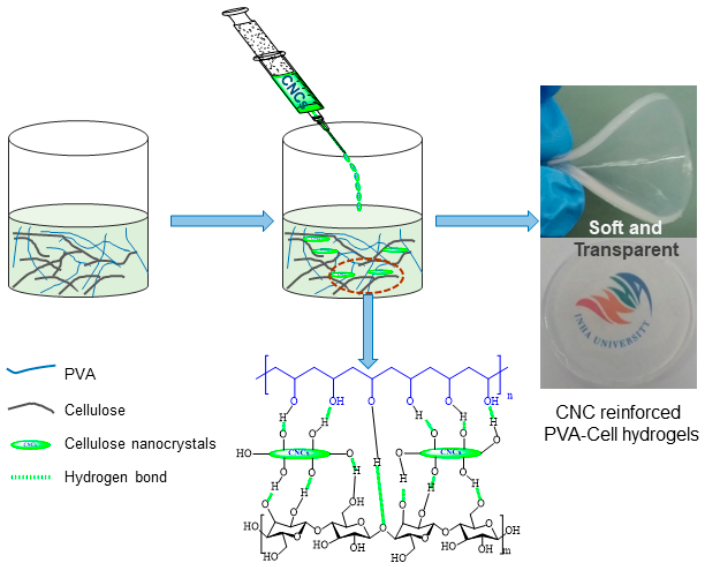
Figure 1. Preparation of CNC-reinforced PVA-Cell hydrogels.